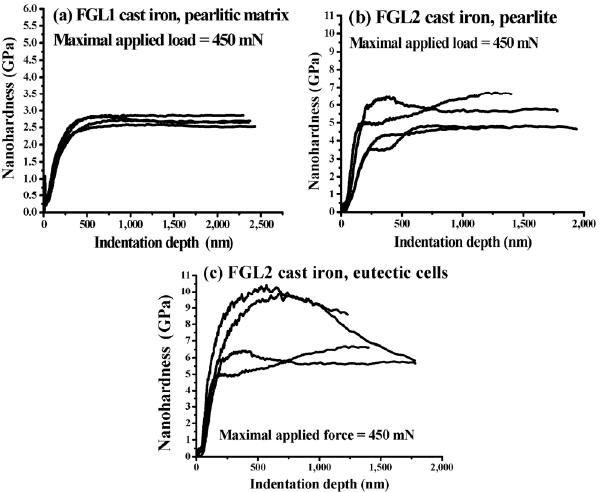
Fig. 2 Pearlite and eutectic cells nanohardnesses of the two studied irons.